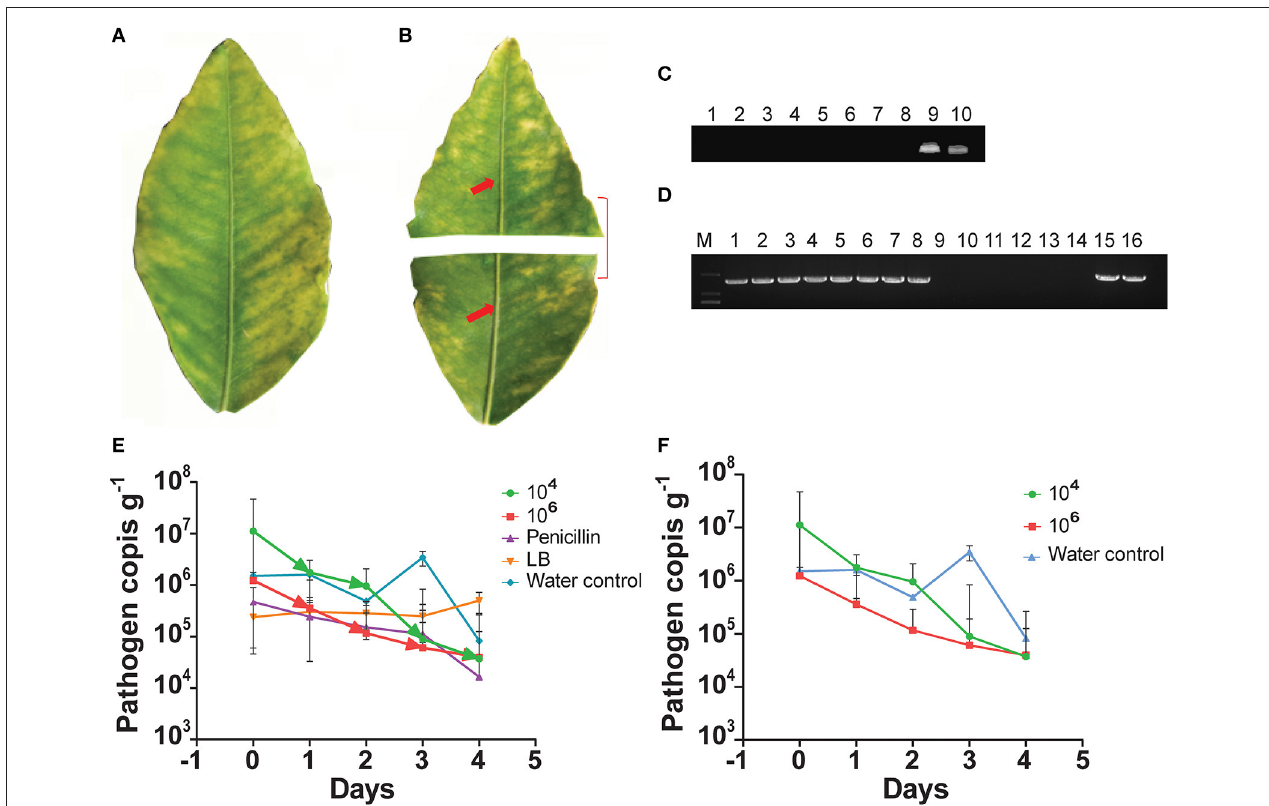
FIGURE 1 | Citrus half-leaf method for reduction of Candidatus Liberibacter asiaticus ( C Las) in the diseased citrus leaves from 0 to 4 days. Sketch of citrus leaf used in novel citrus half-leaf experiment. (A) Whole citrus leaves showing Huanglongbing (HLB) symptoms; (B) Leaf was parted into two parts; the first part was used to detect the C Las pathogen using conventional and quantitative PCR (qPCR); after confirmation, the second part was used in the experiment for Bacillus subtilis ( B. subtilis ) L1-21 treatment. Red arrows indicate leaf midribs used for extraction of DNA for conventional and qPCR; (C) Conventional PCR and diseased citrus leaves were treated with endophytes (10 3 -10 6 cfu ml − 1 ) and antibiotics penicillin (100 µ g µ l − 1 and 500 µ g µ l − 1 ), shenqinmycin (100 µ g µ l − 1 ), and spinosad (100 µ g µ l − 1 ); lane 9, water control; lane 10, positive control; (D) Conventional PCR, before application; Lane 1, citrus leaf sample treated with penicillin; Lane 2, leaf samples treated with spinosad; Lane 3, citrus leaves treated with shenqinmycin; Lane 4, sample in Luria Broth (LB) medium treated with endophytes without shaking; Lanes 5 and 6, samples in LB medium and water, respectively, on shaker; Lanes 7 and 15, diseased citrus leaf in water only; Lanes 8 and 16, positive control; after application: Lane 9, indicated reduction of C Las pathogen with different treatments including penicillin; Lane 10, spinosad; Lane 11, shenqinmycin; Lane 12, endophyte treatment in LB medium without shaking; Lane 13, endophyte treatment in LB medium with shaking; Lane 14, samples in water with shaking; (E) qPCR, pathogen copies per gram of leaves midrib using 10 4 and 10 6 colony forming unit (cfu) ml − 1 of endophyte treatment one time. Pathogen copies g − 1 was calculated based on the standard curve of recombinant plasmid pUC18-382-HLB generated through qPCR. Penicillin was used as a positive control. LB medium and water were used as negative control treatments. Three biological replicates were used for each treatment and each replicate consisted of 12 diseased leaves (including 6 top and bottom half leaves each). The experiment was repeated five times; and (F) Pathogen copies g − 1 of leaves using 10 4 and 10 6 cfu ml − 1 of endophyte and water treatment one time. The values are means ± SD of five replicated